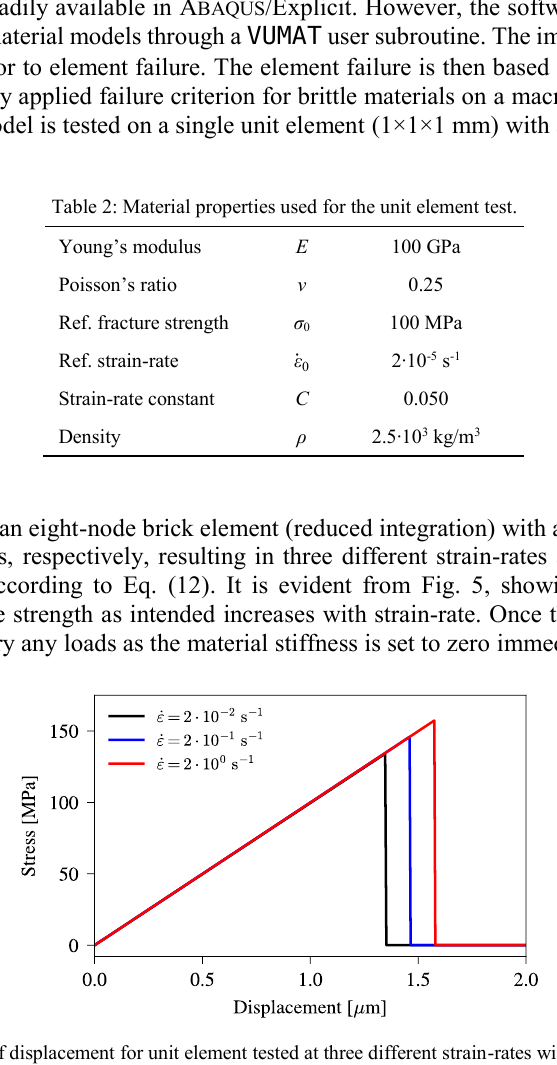
Fig. 5 Stress as a function of displacement for unit element tested at three different strain-rates with immediate element